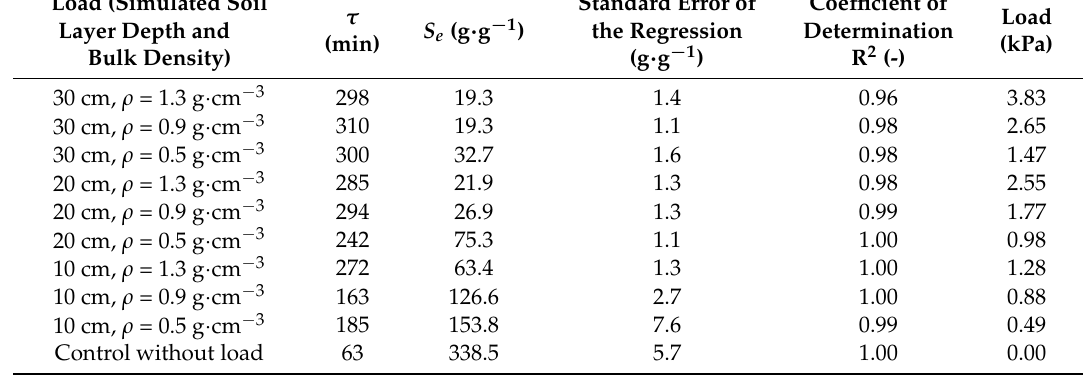
Table 1. Rate parameter ( τ ) and equilibrium swelling ( S e ) for the tested superabsorbent polymer. Load (Simulated Soil Layer Depth and